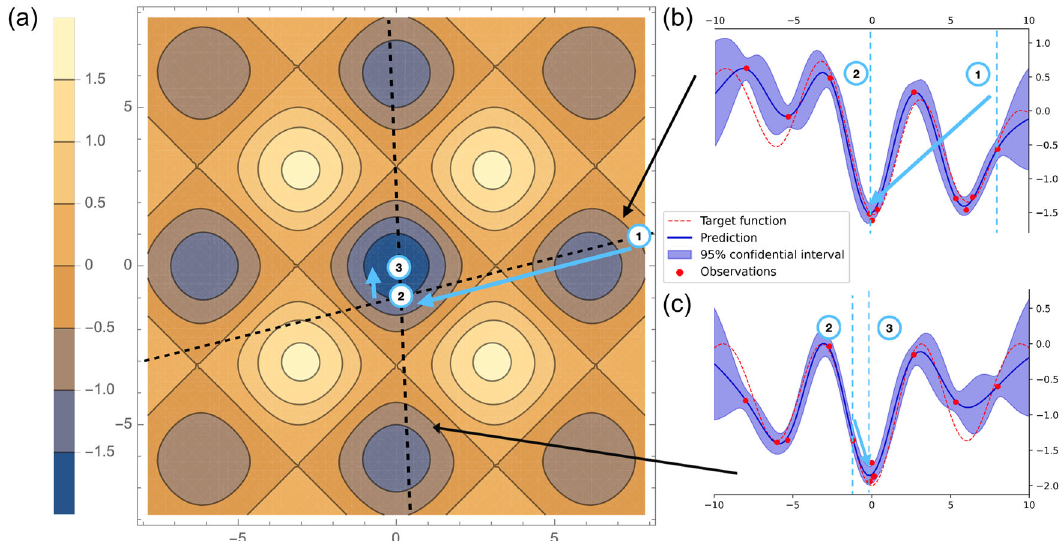
Fig. 1 An illustration of two iterations in SGLBO for minimizing a 2D cost function. a The fi gure represents the updating procedure of SGLBO on the landscape of the cost function. In particular, in the fi rst iteration, at an initial point 1, we estimate a direction of the gradient of the cost function based on SGD and perform BO on the 1D subspace in this direction to estimate the optimal step size. b Then, we reach point 2 from the point 1 by moving in the estimated direction by the estimated optimal step size. c Next, at point 2, we perform the same procedure of estimating the gradient based on the SGD and estimating the optimal step size by the BO on the line of the 1D subspace, to move from point 2 to point 3. We iterate these procedures until SGLBO converges or consumes a preset number of measurement shots. After all these iterations, SGLBO returns a suf fi x average over the points visited in the iterations as an